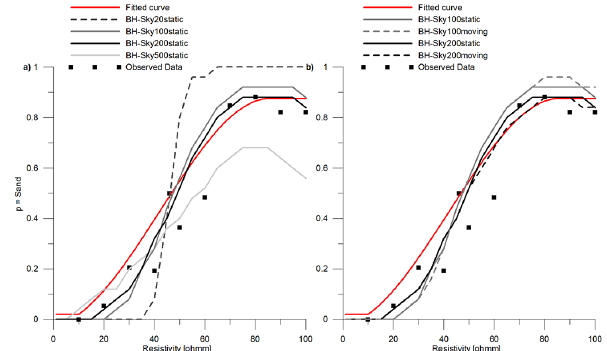
Figure 11. The simulated facies probability–resistivity bias based on sets of realizations conditioned to differently sampled soft data sets (based on 25 realizations): (a) static sampling at different sam- pling distances and (b) stationary and moving sampling at different sampling distances. The simulated sand probability is paired with the original resistivity value, grouped into 5 (cid:127) m bins and then plot- ted as the median for each bin. Also shown are the observed data and the fitted curve from the histogram which is desired to be re-